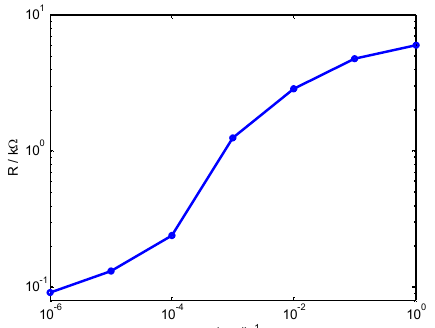
Fig.22: Functional dependence of the measured real part of the impedance at 10 kHz with respect to the concentration of the KCl- solution